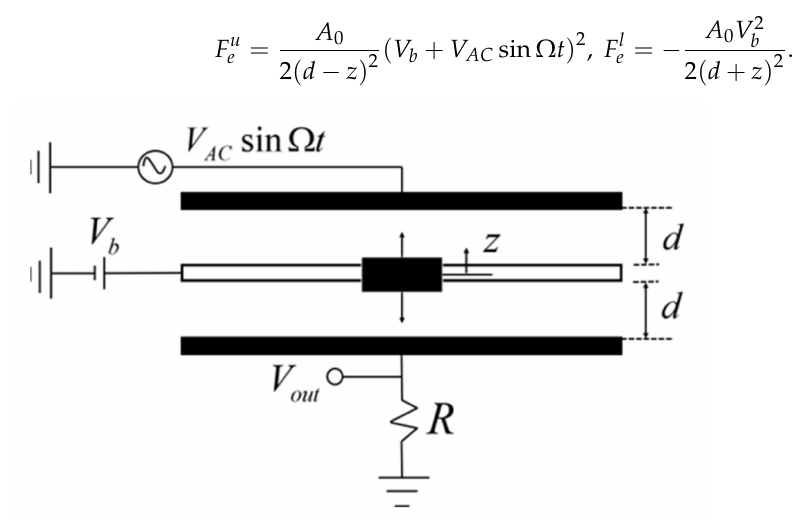
Figure 1. Simplified diagram of a bilateral electrostatic micro resonator.